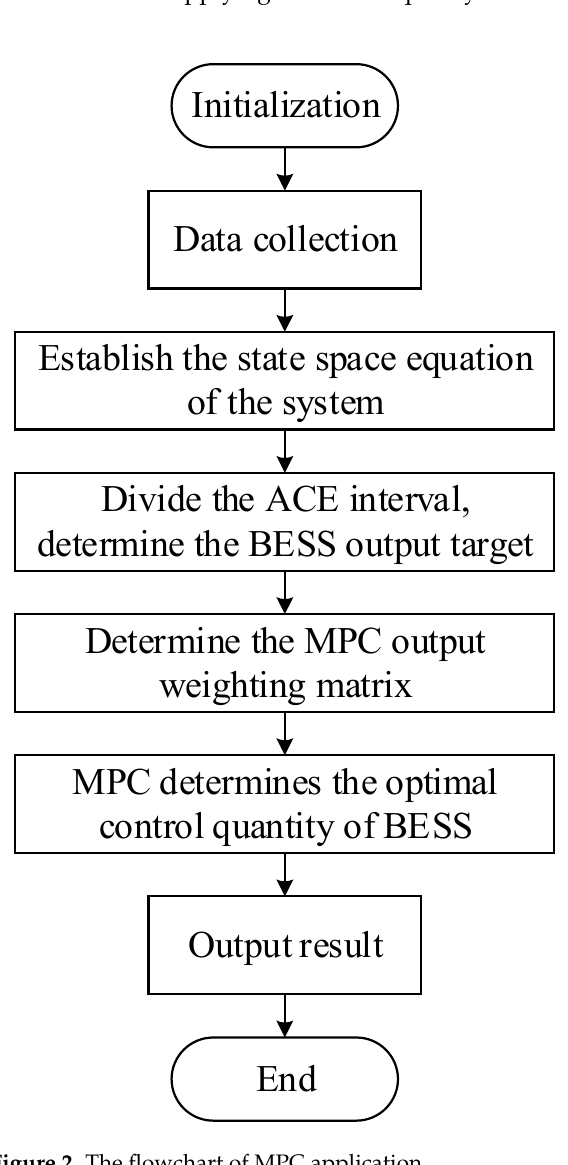
Figure 2. The flowchart of MPC application.